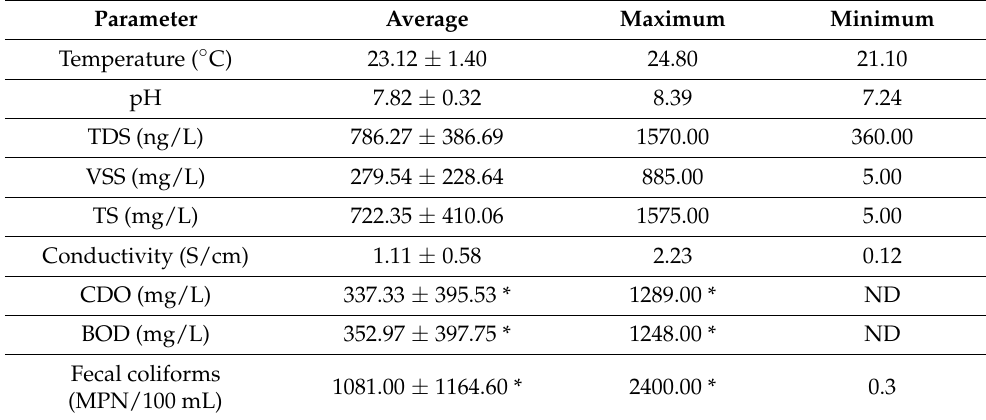
Table 3. Summary results of the obtained parameters of the water from El Pueblito river.